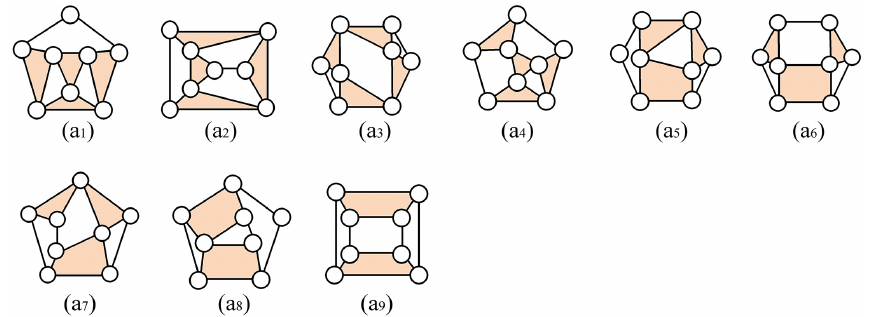
Figure 10. Generalized chains for the (6, 8) atlas (Yan, 1998).